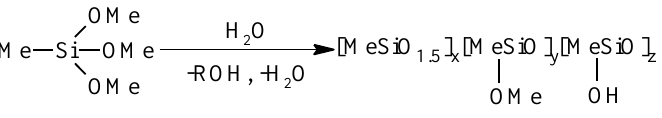
Figure 1. General scheme of the reaction for MWHP of MTMS.